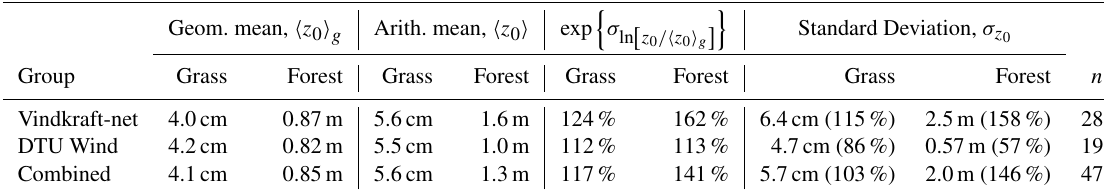
Geom. mean, (cid:104) z 0 (cid:105) g